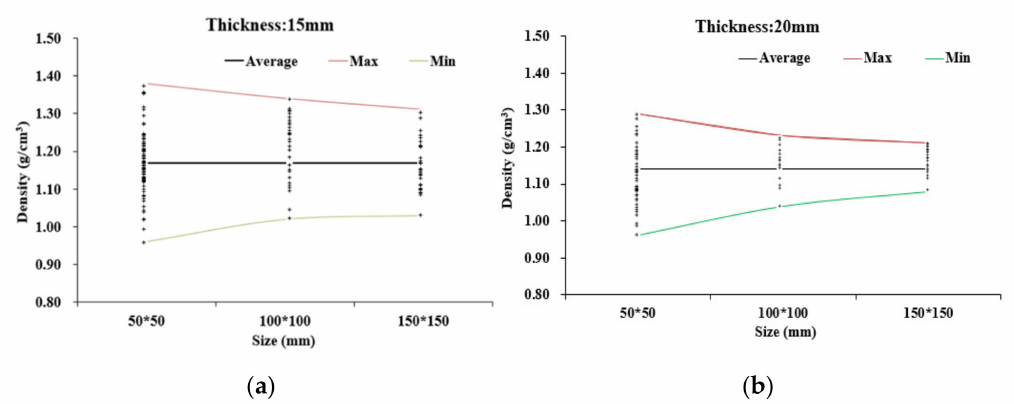
Figure 6. Spread of point densities by specimen size for ( a ) 15- and ( b ) 20-mm panels. A simplified function adapted from Dai and Steiner [23], developed to predict density variance based on element size and panel thickness, provides a predictive model for SD, based on density specimen side length (a) and panel thickness (T), given below: √ σ = f(a)/